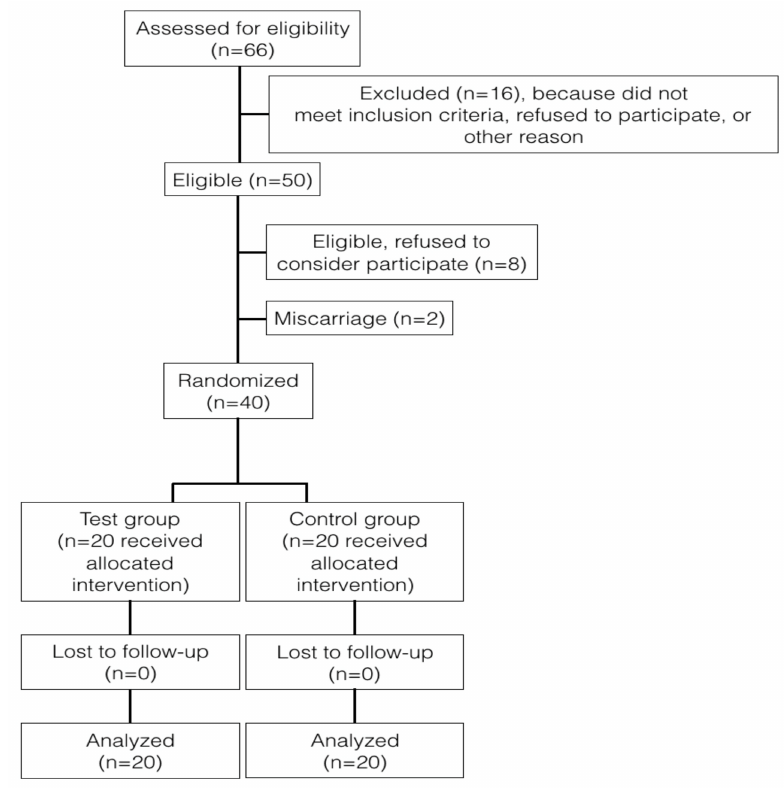
Figure 2. Flow chart to show participants progress through the study. Table 1. Demographic description of the study